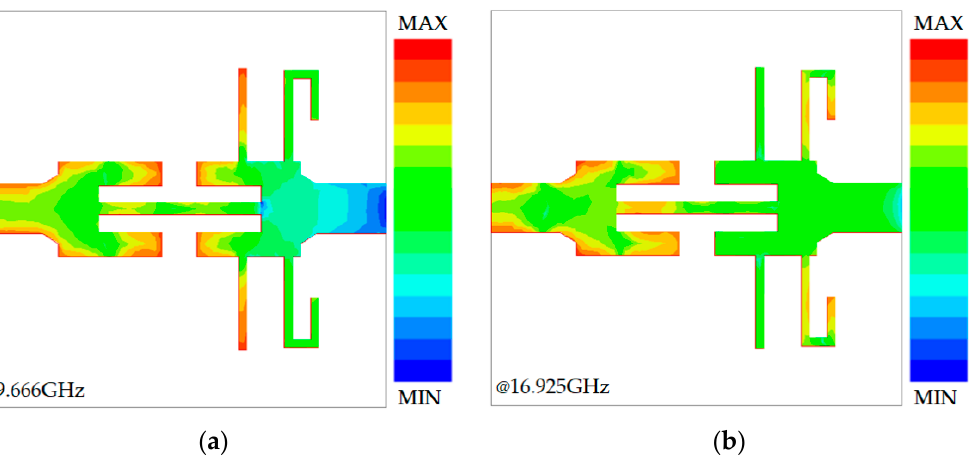
Figure 4. Current distribution of top coupling patch at the frequency of transmission zeros: ( a ) 9.666 GHz; ( b ) 16.925 GHz.